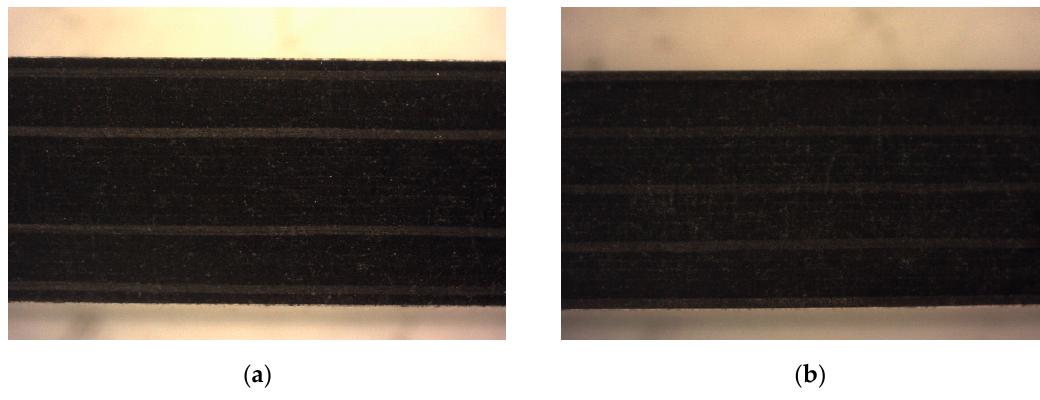
Figure 5. SOM image of the cutting front in: ( a ) Stack CFRP/UNS A97075; ( b ) CFRP plate; ( c ) UNS A97075 plate.